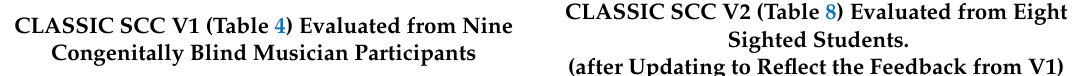
Table 8. User feedback for CLASSIC SCC V1 and CLASSIC SCC